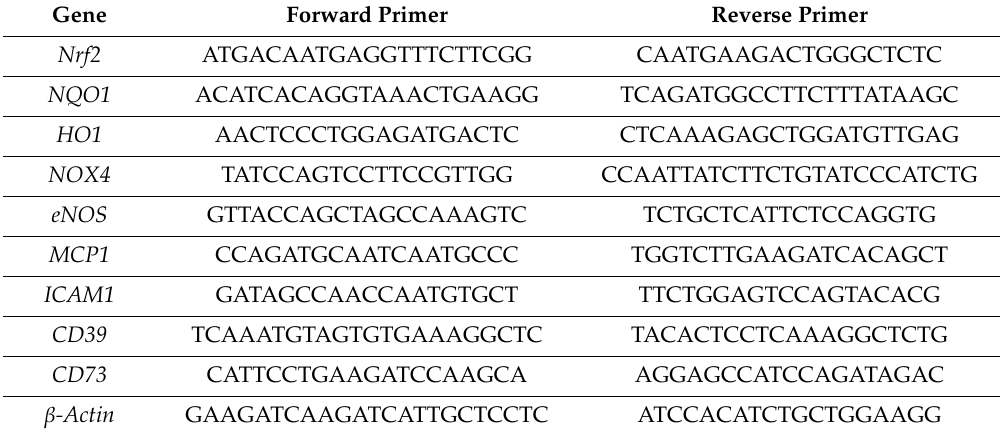
Table 1. List of genes with their primer sequences used for qPCR.